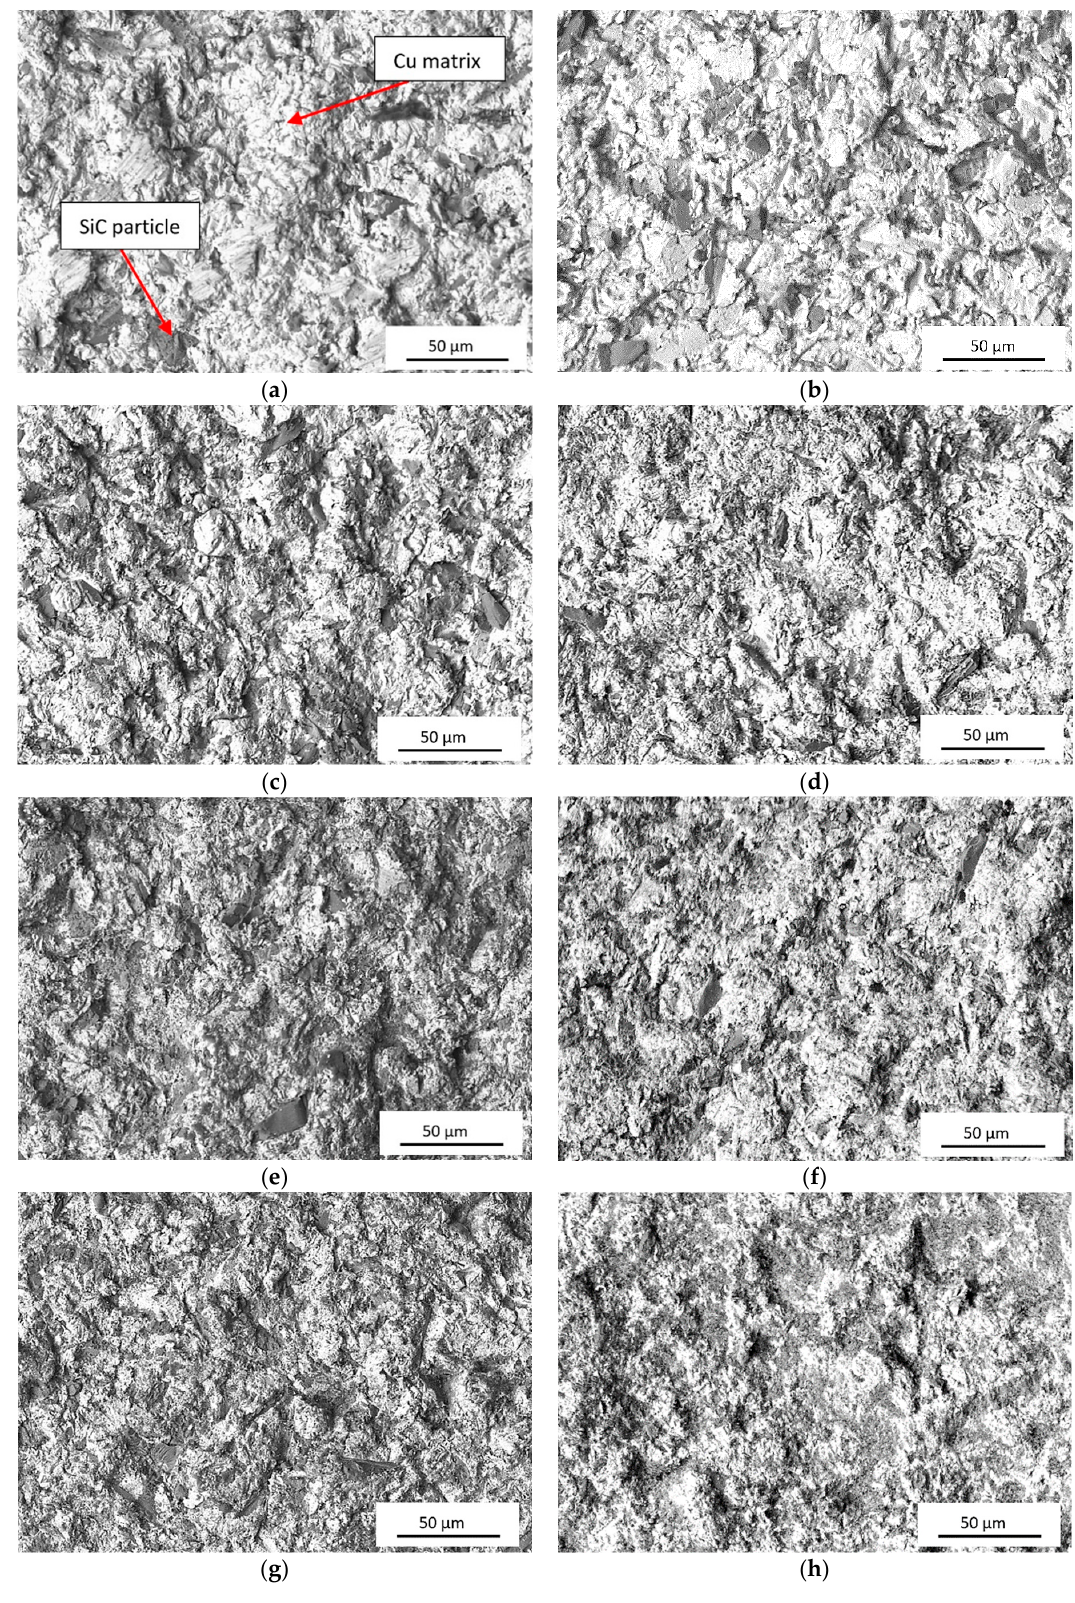
Figure 8. SEM micrographs (SE) of flat coatings surface—ECu/1/F ( a ), OCu/1/F ( c ), ECu/2/F ( e ), and O-Cu/2/F ( g ); and wavy coatings surface—ECu/1/W ( b ), OCu/1/W ( d ), ECu/2/W ( f ), and OCu/2/W ( h ).